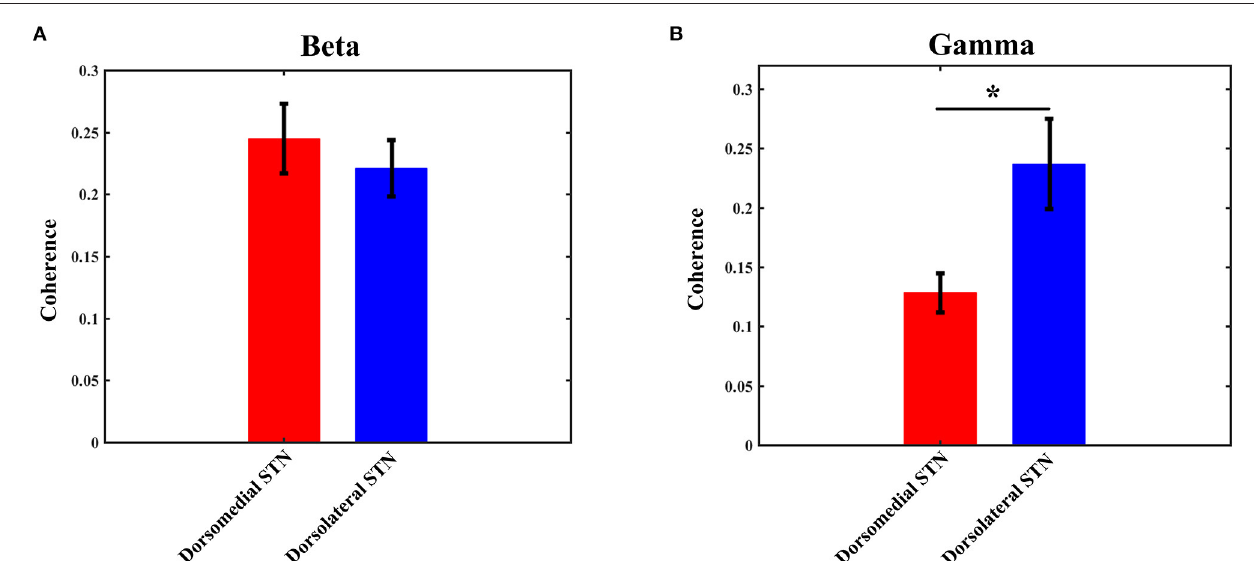
FIGURE 4 | Average beta (A) / gamma (B) coherence for the dorsomedial (red) and dorsolateral (blue) STNs. *Indicates p < 0.05. STN, subthalamic nucleus.